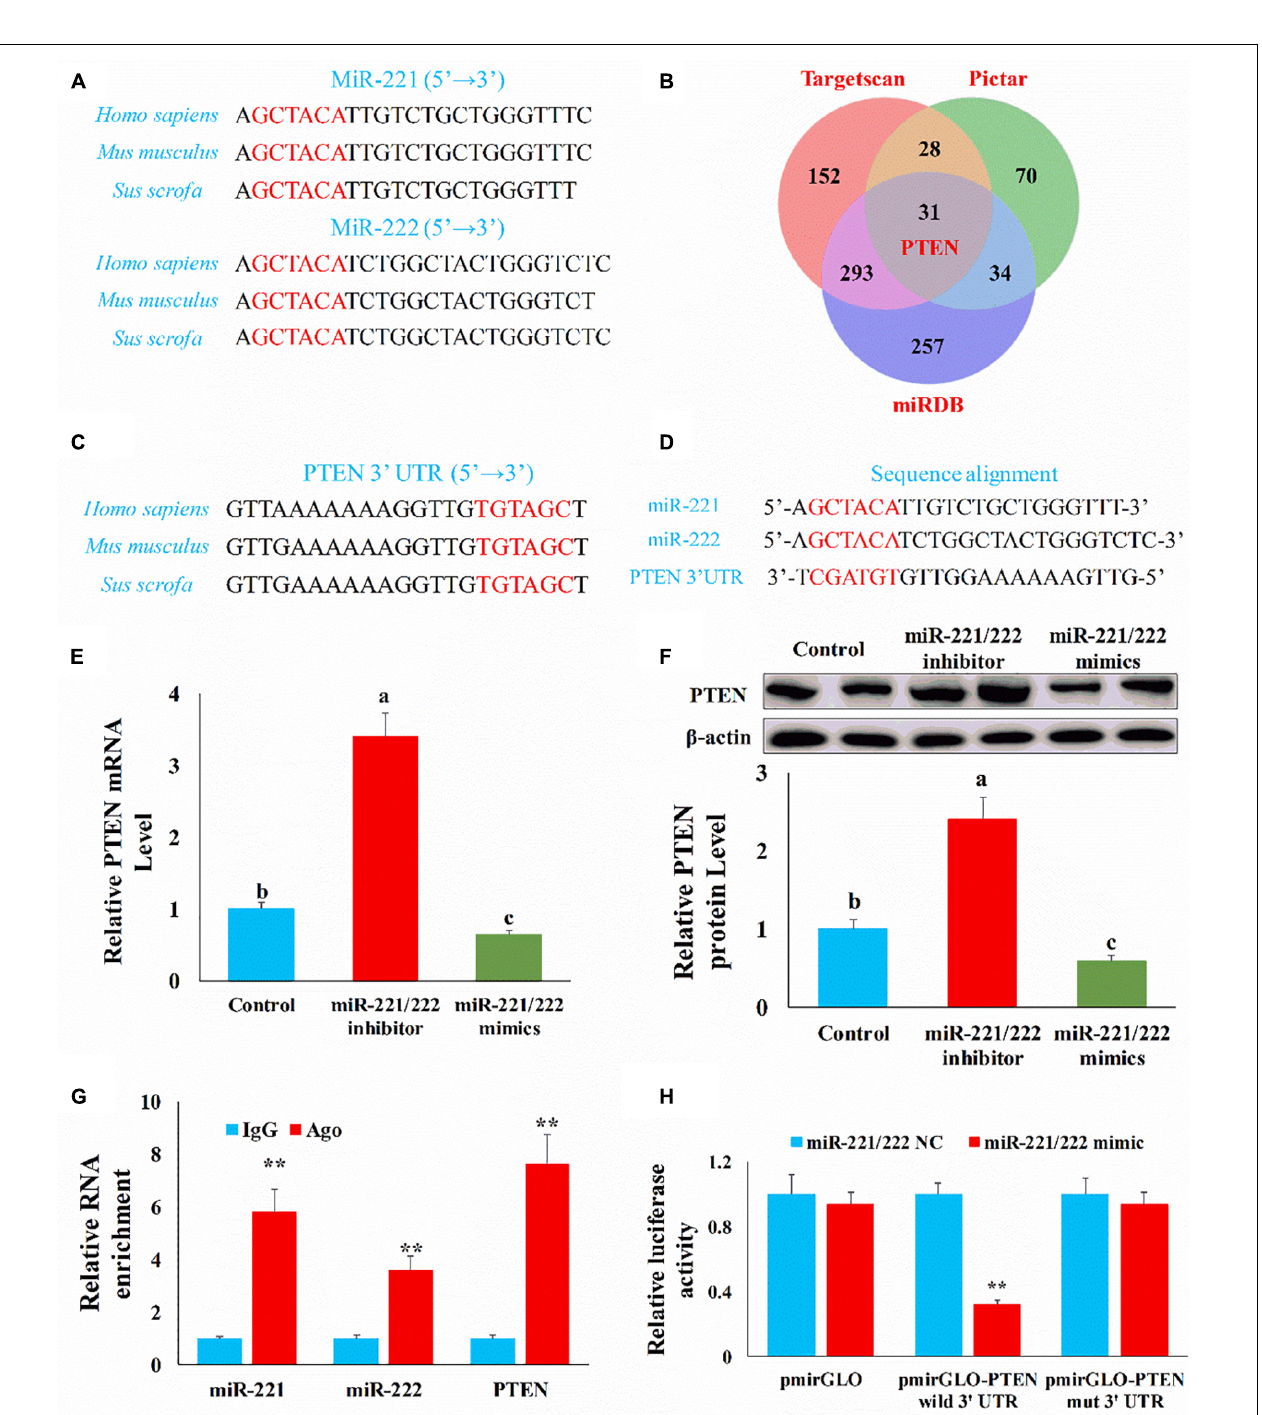
FIGURE 5 | PTEN was the target gene of miR-221/222. (A) The mature miR-221/222 sequence in different species. (B) Venn diagram showed the target genes of miR-221/222 obtained from different databases. (C) The alignment result of PTEN 3 (cid:48) UTR sequence from different species. Red represented the complete complementary sequence of the PTEN 3 (cid:48) UTR. (D) The complementary pairing of the target gene PTEN 3 (cid:48) UTR and miR-221/222. (E) qRT-PCR result confirmed PTEN mRNA level was negatively correlated with miR-221/222 level. (F) WB result confirmed PTEN protein level was negatively correlated with miR-221/222 level. (G) The interaction of miR-221/222 and PTEN in RNA-induced silencing complexes through RNA immunoprecipitation. (H) Luciferase reporters were transfected into HEK-293T cells with either miR-221/222 NC or miR-221/222 mimics, respectively. Luciferase value was measured 24 h after transfection. The results were presented as mean ± SEM of triplicate independent experiments for each group. Bars with different letters indicate they are significantly different ( p < 0.05); ** p < 0.01.